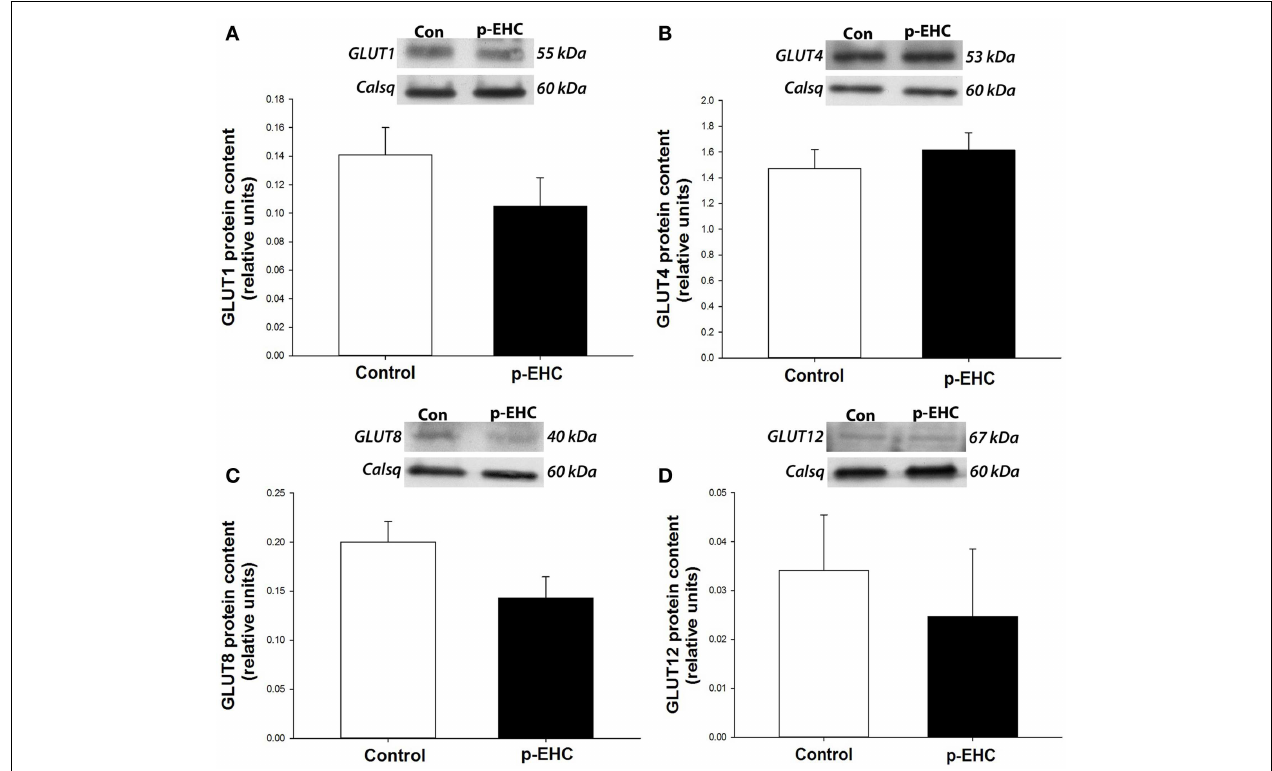
Bottom panels: mean ± SE protein expression of GLUTs 1 (A) , 4 (B) , 8 (C) , and 12 (D) do not differ in the ventricular myocardium of horses treated with a prolonged, euglycemic, hyperinsulinemic clamp (p-EHC), compared with control